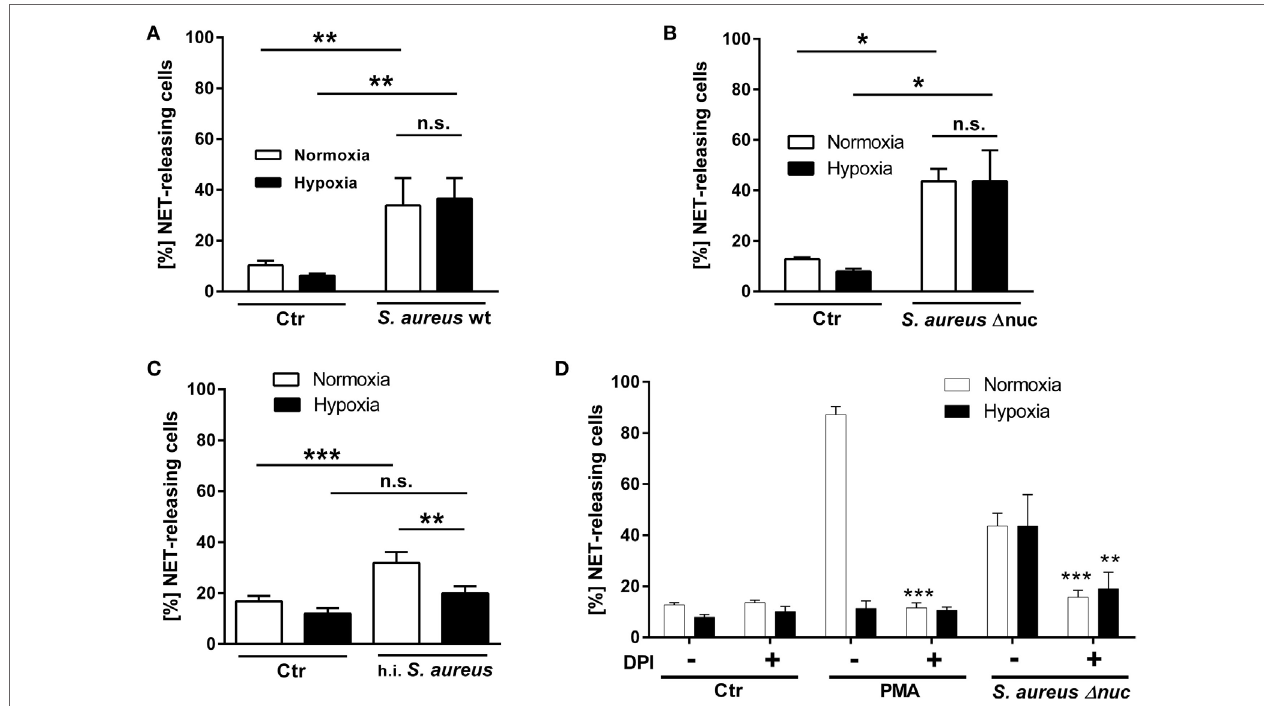
FiGUre 5 | S. aureus -induced net formation . Neutrophils were preincubated under normoxic or hypoxic conditions for 2 h and further co-incubated for 3 h under the respective oxygen concentration with S. aureus wt (living and h.i.) and S. aureus Δ nuc. Formation of NETs was microscopically analyzed and calculated as (%) NET-releasing cells. Neutrophils stimulated with S. aureus wt (a) and S. aureus Δ nuc (B) release significantly more NETs compared to the amount of spontaneous NET formation both under normoxia as well as under hypoxia (normoxia: S. aureus wt: 33.9 ± 10.8% and ctr: 10.3 ± 1.9%/ S. aureus Δ nuc: 43.6 ± 5% and ctr: 12.8 ± 0.9%, hypoxia: S. aureus wt: 36.9 ± 12.8% and ctr: 8 ± 1.1%/ S. aureus Δ nuc: 43.6 ± 12.3% and ctr: 8 ± 1.1%). (C) The h.i. S. aureus caused significantly higher numbers of NET-releasing cells compared to untreated control under normoxia, while this difference was highly decreased under hypoxic conditions (normoxia: h.i. S. aureus : 31.8 ± 4.3% and ctr: 16.8 ± 2.1%, hypoxia: h.i. S. aureus : 20 ± 2.8% and ctr: 12.3 ± 2.1%), n = 2 independent experiments with each n = 6 images (total n = 12). (d) Neutrophils were treated with 10 μ g/ml DPI to block NADPH oxidase activity. Formation of NETs was statistically analyzed compared to respective control in the absence of DPI by one-tailed unpaired Student’s t